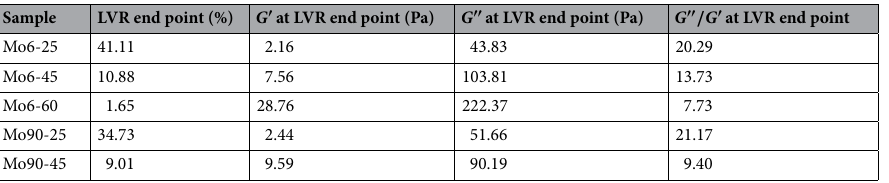
Table 1. The oscillatory strain sweep parameters in the LVR.